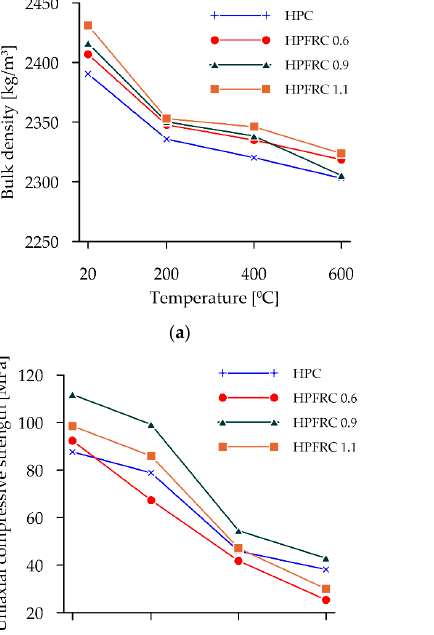
Figure 6. HPFRC 1.1 samples. From left: without heating, 200 °C, 400 °C, 600 °C.